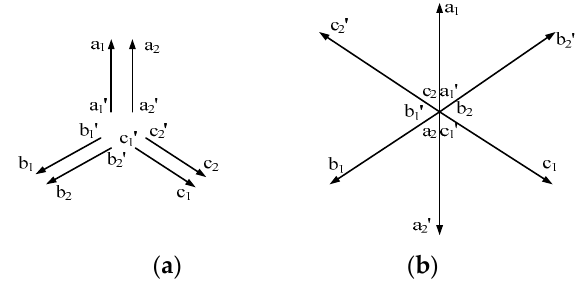
Figure 6. Output voltage phasors ( a ) Representation 1 ( b ) Representation 2.